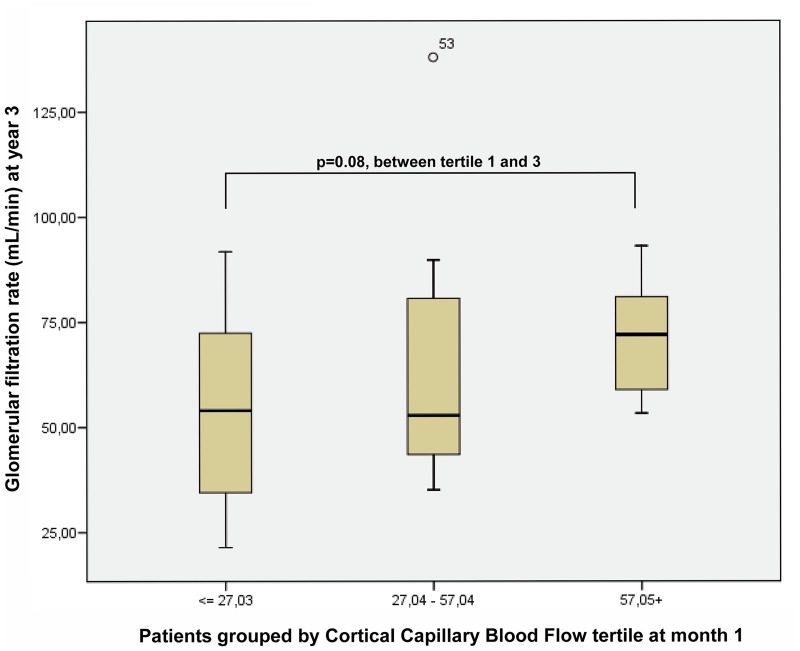
Box diagrams representing GFR values reached at year 3 by various groups of patients, grouped by CCBF tertile at month 1.